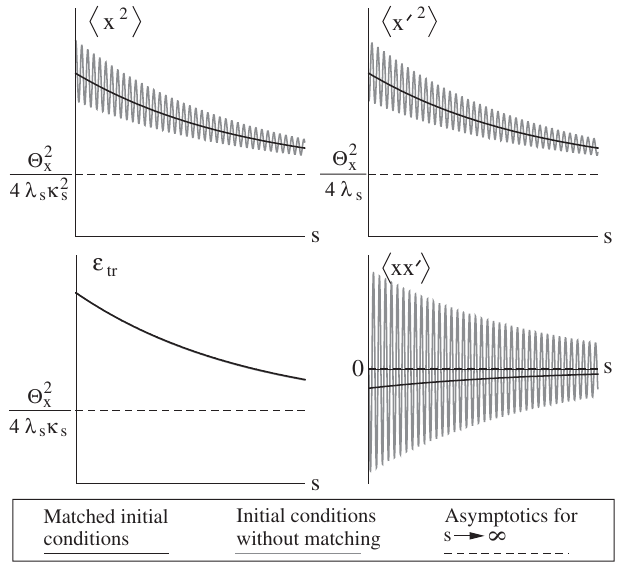
FIG. 2. Stylistic impression of the behavior of the second moments of the beam and transverse emittance due to ionization cooling in the cases of matched initial conditions (black curves) and unmatched ones (gray curves).